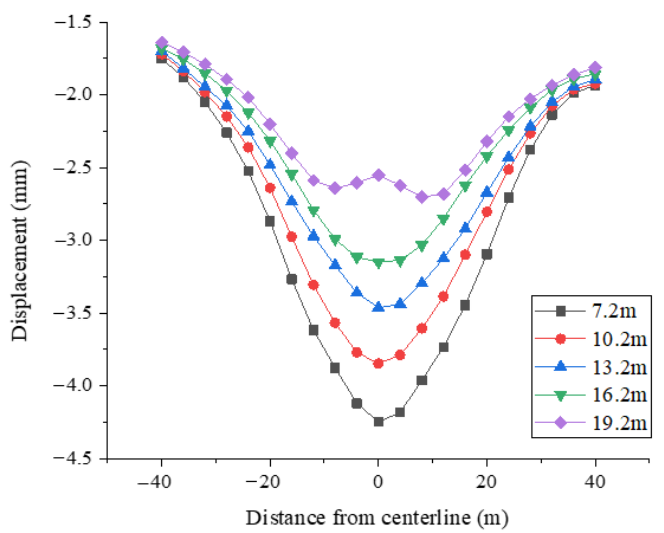
Figure 13. Lateral variation curve of ground settlement for different tunnel spacing at 10 m depth in excavation direction.